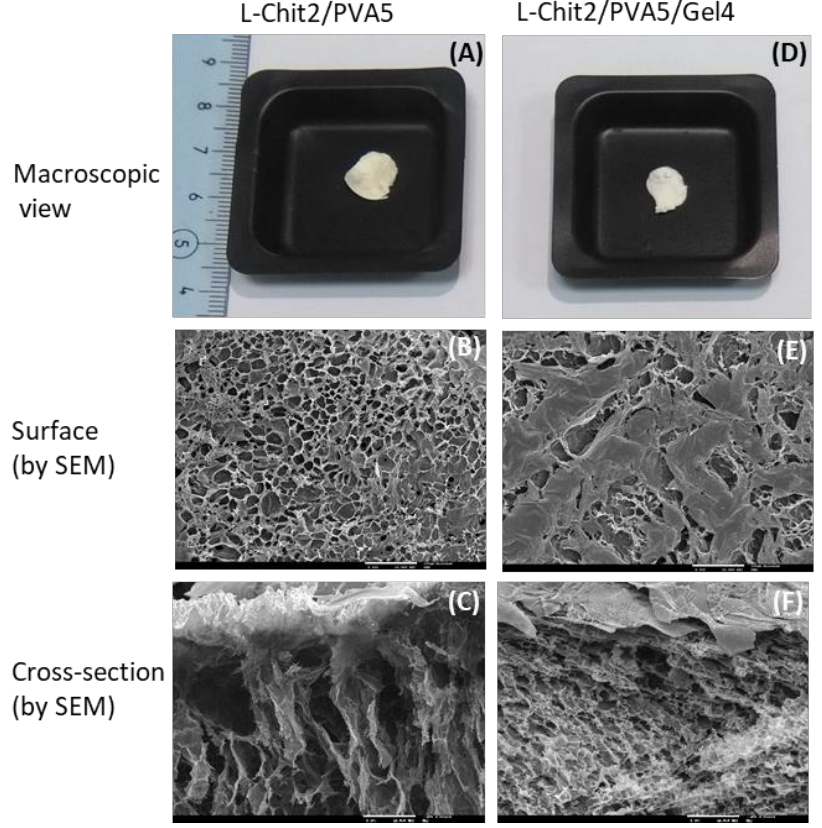
Figure 3. Macroscopic and SEM images of irradiated (10 kGy) L-Chit/PVA-based membranes with and without gelatin. (scale bar 200 µm).